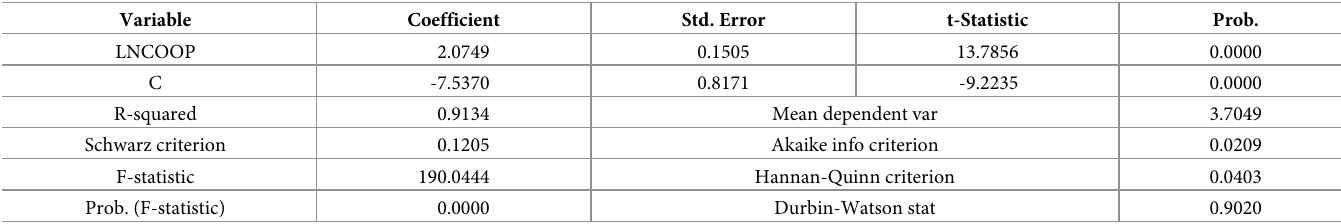
Table 4. External R&D E-G two-step regression